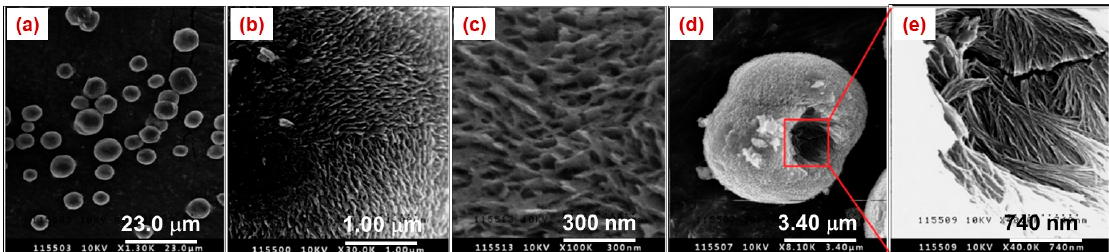
Figure 14. SEM images of: ( a ) PI aerogel microparticles; ( b , c ) their surfaces; ( d , e ) their interior. Copyright (2014) Wiley. Used with permission from Ref. [99].